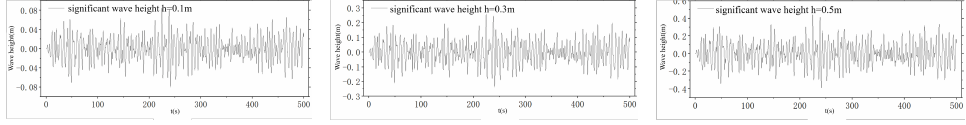
Figure 20. From left to right: wave surface curve of PM dual-parameter spectrum under different significant wave heights (0.1 m, 0.3 m, 0.5 m).